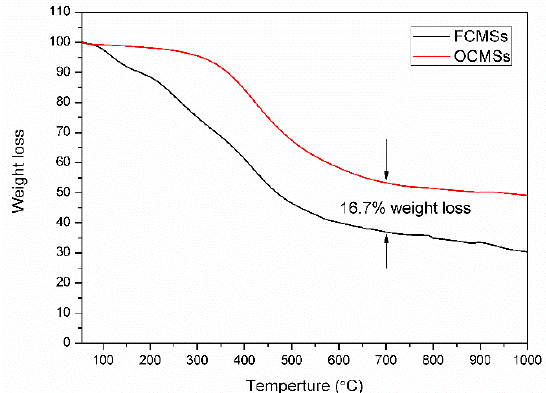
Figure 5. The TG spectra of FCMSs and OCMSs.